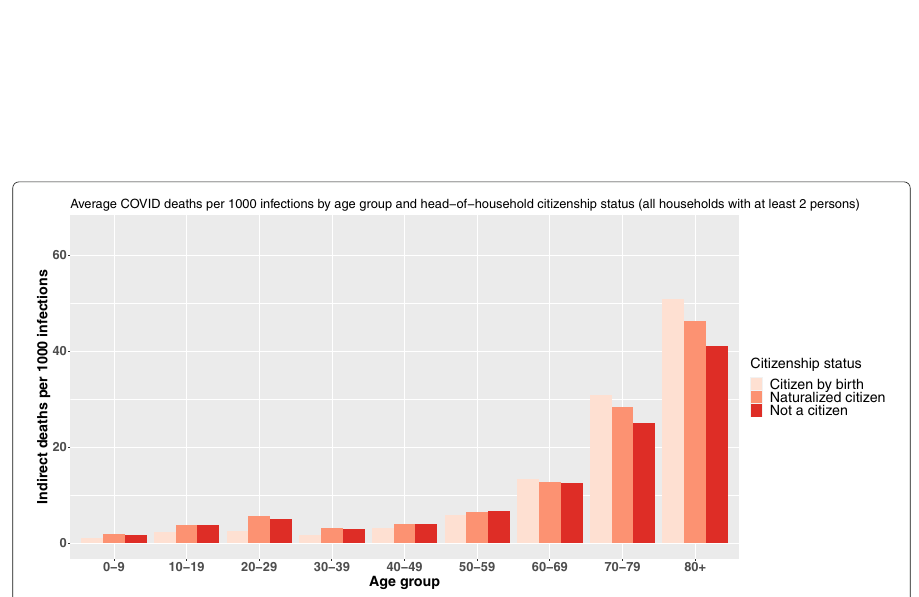
Fig. 11 Average COVID-19 deaths per 1000 infections by age group and head-of-household citizenship status (2+